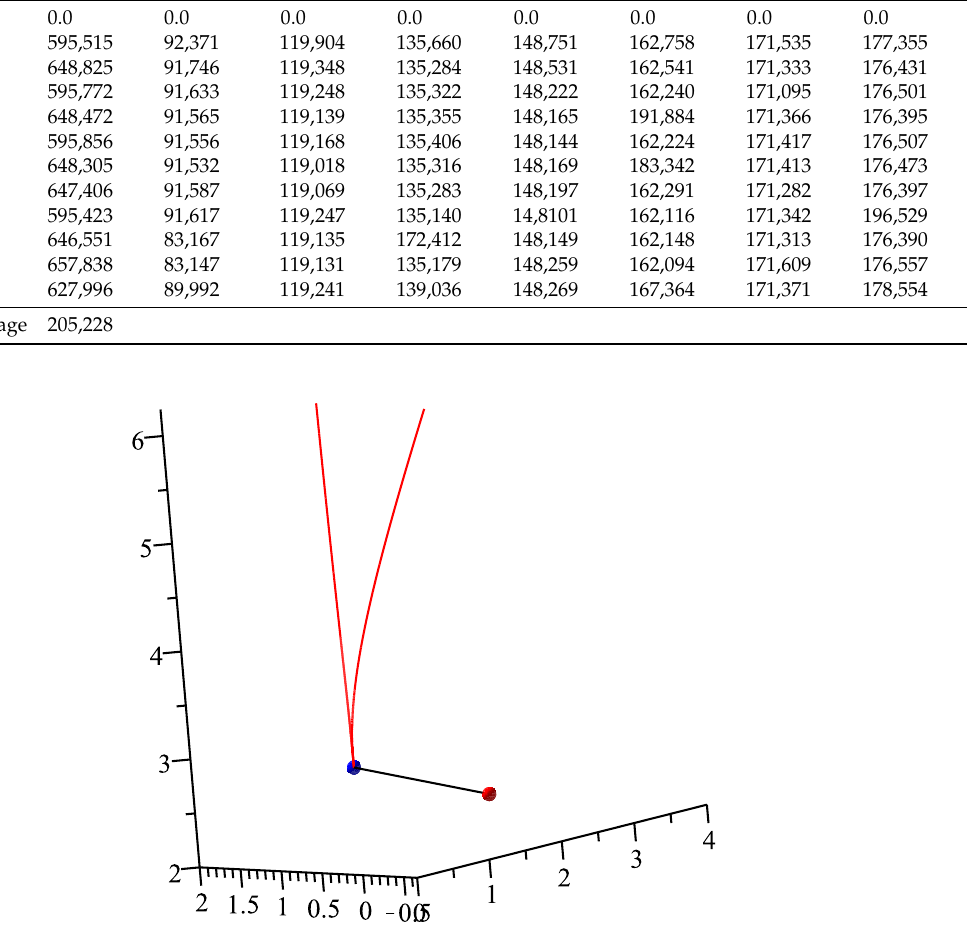
Figure 6. Geometric illustration for the test point p = (2.0, 4.0, 2.0) of Example